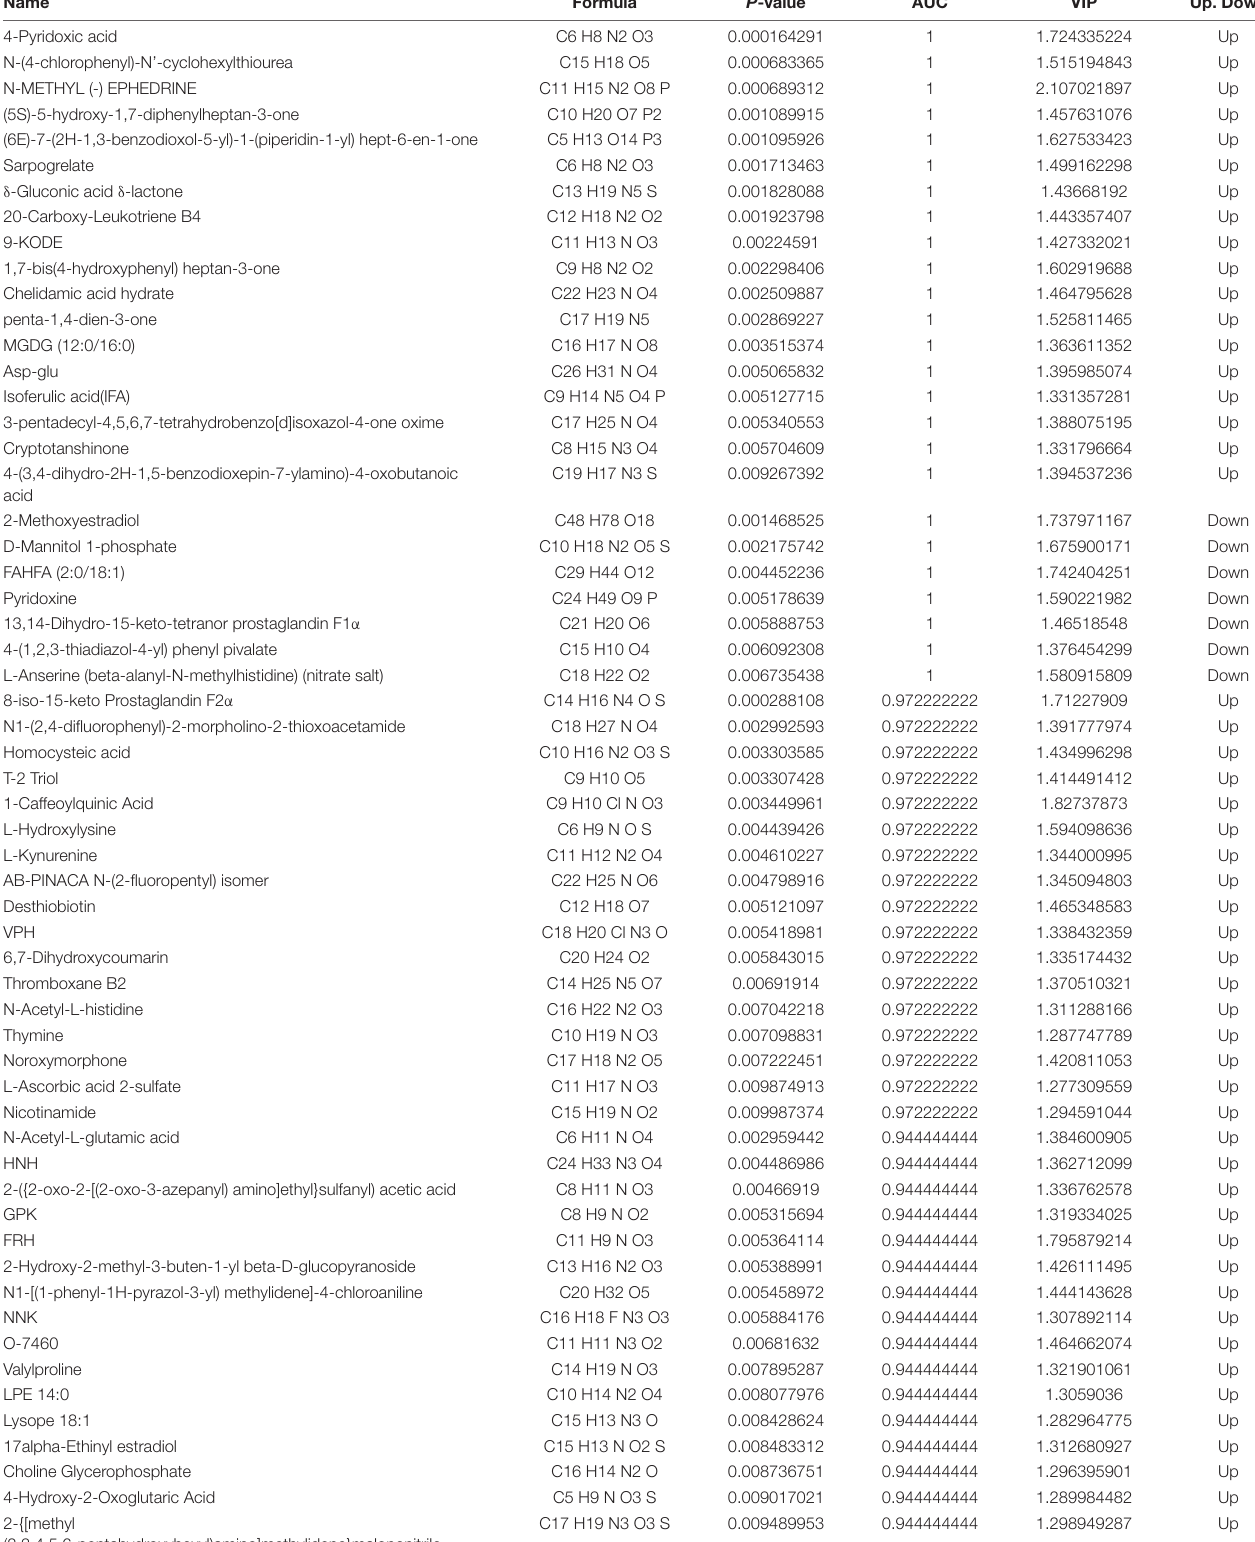
TABLE 6 | Differential metabolites ( p <